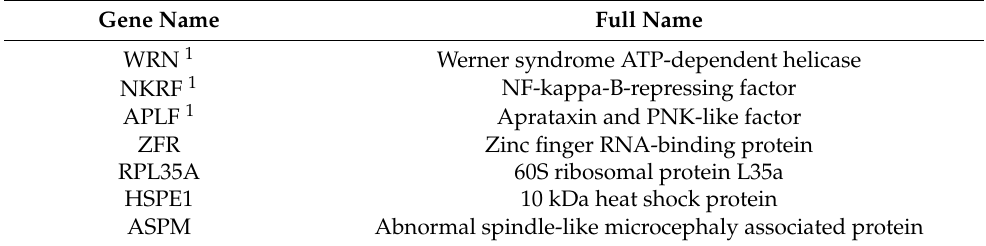
Table 2. List of Ku70 ∆ vWA-specific candidate protein interactors that appeared in three biological replicates of Ku70 ∆ vWA-BioID2. Final Ku70 ∆ vWA candidates are shared with full-length Ku70 results and absent from the Ku70 vWA protein candidates list. Final candidates were filtered using the negative control cell lines, HEK293 and